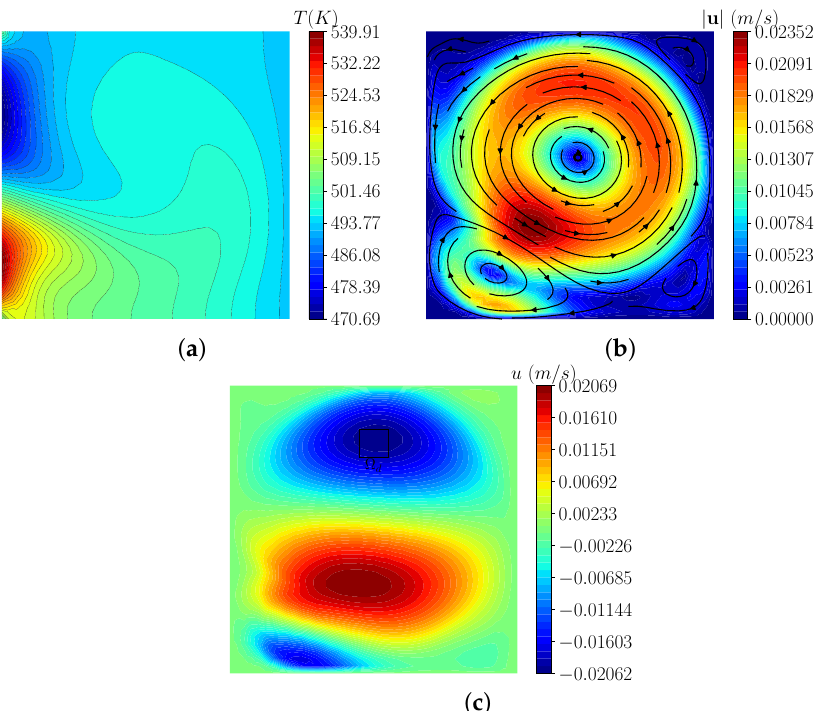
Figure 8. Velocity matching case with Dirichlet boundary control—Case 2: optimal solution for λ = 10 − 12 . Contours of the temperature field T ( a ); contours and streamlines of the velocity field u ( b ); contours of the x -component of the velocity field u ( c ). The velocity magnitude is indicated by the region where the objective is